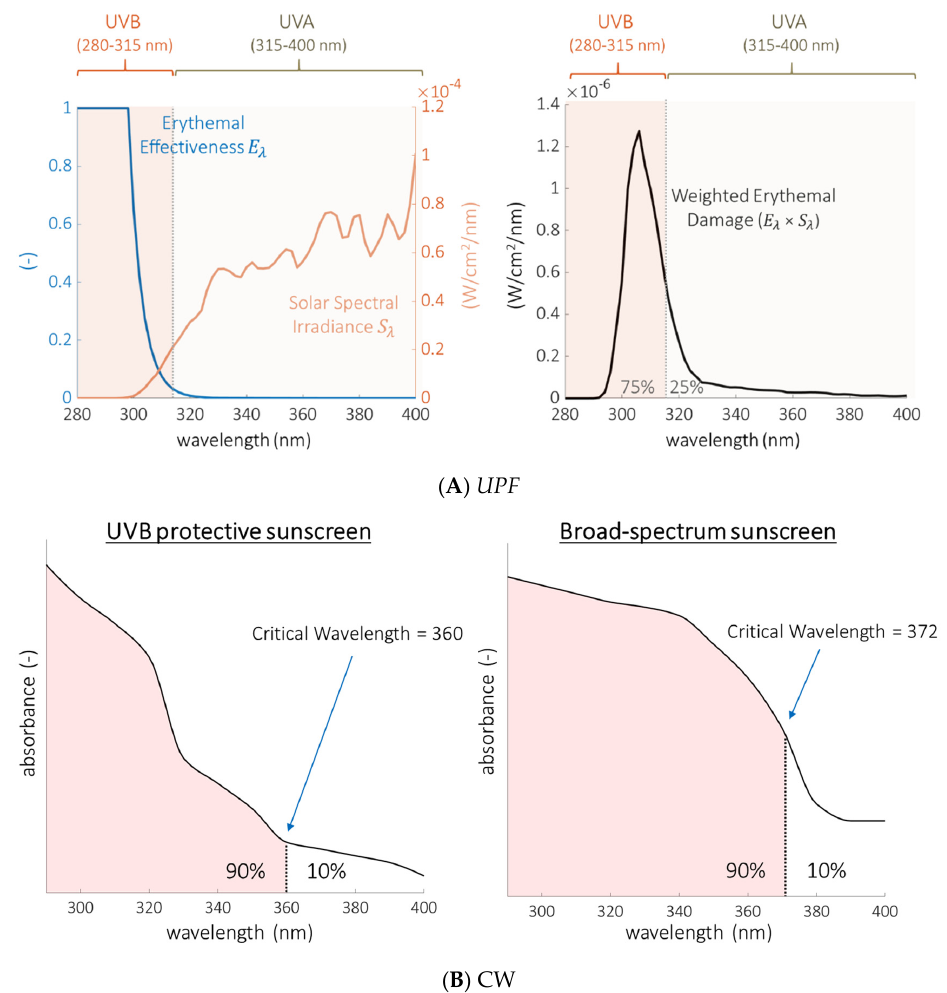
Figure 1. Ultraviolet protection factor ( UPF ) is primarily a measure of UVB protection whereas critical wavelength (CW) is a measure of the degree of broad ‐ spectrum protection. ( A ) UPF is a mathematical function designed to recapitulate sun protection factor ( SPF ) from a laboratory measurement of transmittance and is weighted toward the UVB portion of the spectrum. Left: Plots of the erythemal effectiveness function ( E λ ) and the solar spectral irradiance ( S λ ) over the UVR spectral range. Right: The product of E λ and S λ has a peak that lies predominantly (75%) within the UVB range (280–315 nm). Very little of the UPF function comes from wavelengths longer than 360 nm, where the UVR intensity is highest but the erythemal effectiveness is near zero [48]. ( B ) Visual representation of the CW as the wavelength below which 90% of the total absorbance (area under the curve) in the UVR region is contained. Left: Hypothetical sunscreen that primarily blocks UVB radiation has a critical wavelength below the 370 nm threshold required by the FDA to be labeled broad ‐ spectrum. Right: Hypothetical sunscreen with improved UVA blocking performance meets the broad ‐ spectrum criterion. A sunscreen could meet the CW criterion of 370 nm without comprehensively blocking UVA radiation.